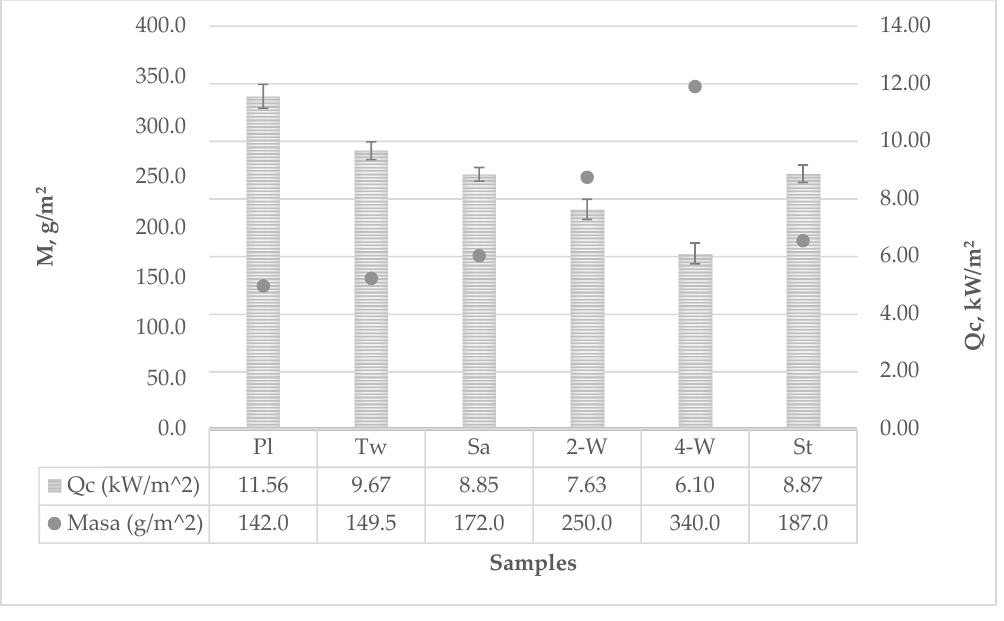
Figure 3. Leaked heat flux density through the sample to the calorimeter diagram.